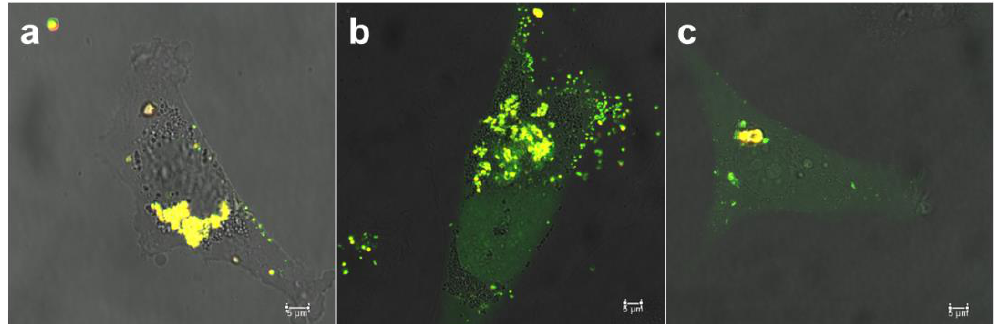
Figure 7. Microscopy images of net surface charge effect on the endosomal escape of calcein loaded in ( a ) POPG-, ( b ) DOPC- and ( c ) DOTAP-DOPE@PEI-MSNs. Surface charge of second lipid in lipid bilayer (POPG—negative charge, DOPC—neutral, and DOTAP—positive charge) influence the drug/calcein release from endosomes, visualized as uniform spreading in water containing cytoplasm compartment. Overlay of bright field and fluorescent signal from TRITC labeled tLB@MSNs (red) and calcein (green).